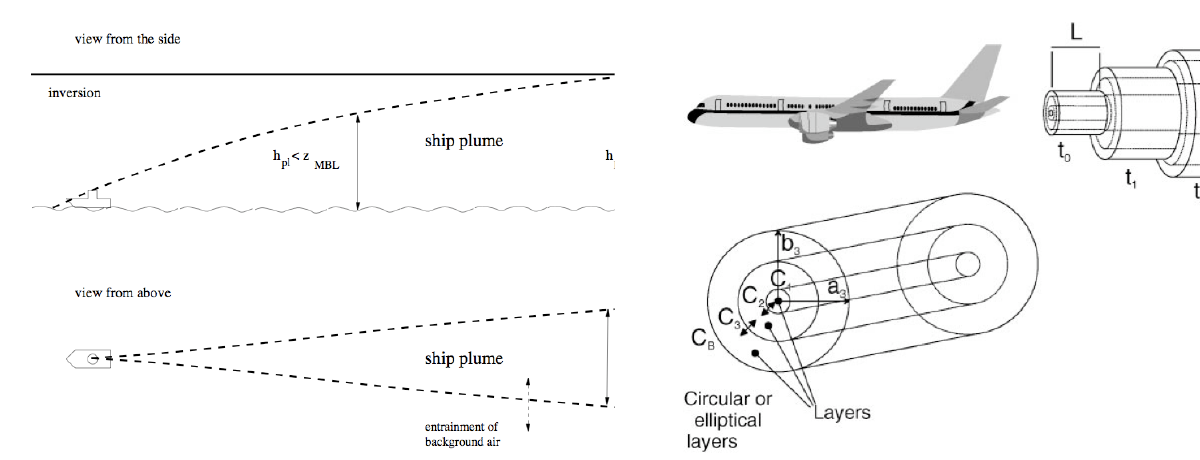
Fig. 3. Multilayer plume model of an aircraft plume. Reprinted from Kraabøl et al. (2000b), Atmospheric Environment, Copyright (2000), with